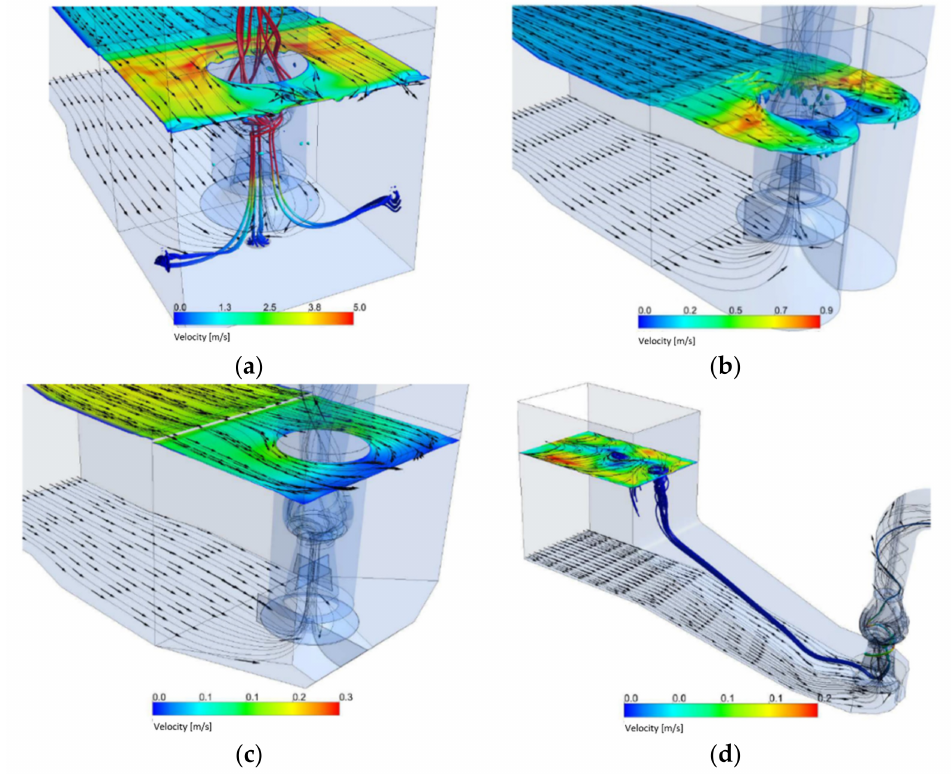
Figure 14. Plot of volume fraction isosurface with velocity contour overlay, approach flow streamlines, and vortex streamline: ( a ) case 1, ( b ) case 2, ( c ) case 3, and ( d ) case